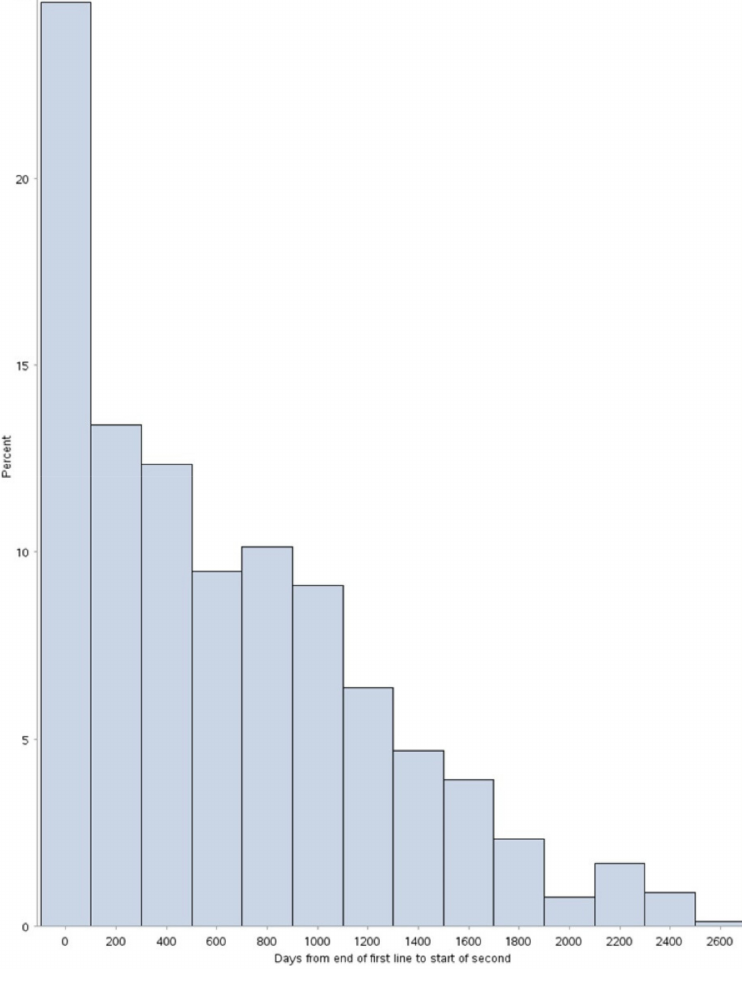
Figure A2. Distribution of time from end of first line treatment to start on second line